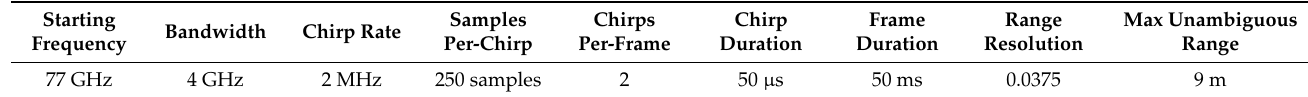
Table 1. Radar parameter setting.